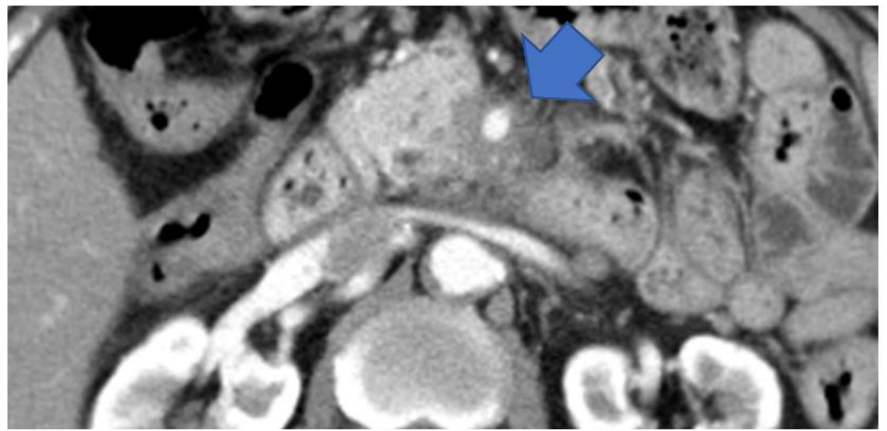
Figure 5. CECT shows tumors surrounding the SMA in the pancreatic uncus area (arrow). CECT, contrast-enhanced computed tomography; SMA, superior mesenteric artery. Type III : Cases that form a mass located in the groove region (Figure 6).